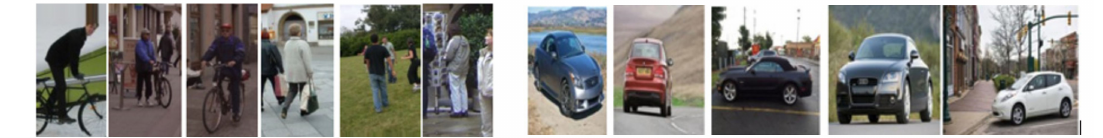
Figure 11. Training data sample images from [24–27].